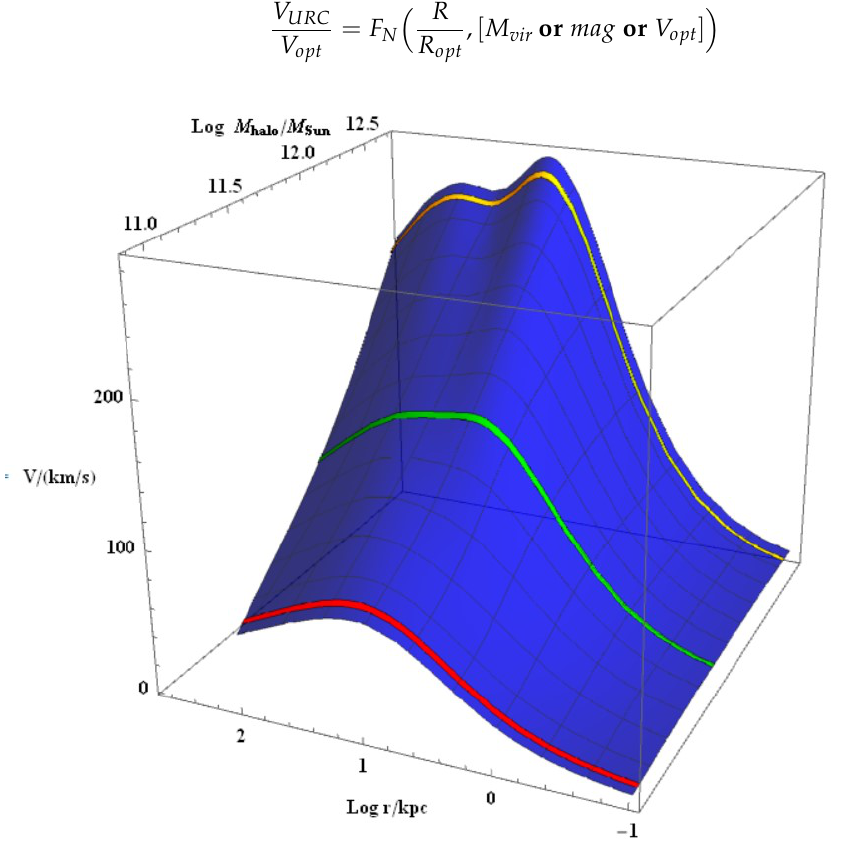
Figure 7. The universal rotation curve (URC) for spirals. The circular velocity V ( r ; M vir ) is plotted ( right to left ) out to R vir as a function of log radius and LogM vir . The 3 RCs plotted as yellow bands correspond to the cases Log M vir / M (cid:12) = 11 ± 0.03,11.9 ± 0.03,12.3 ±